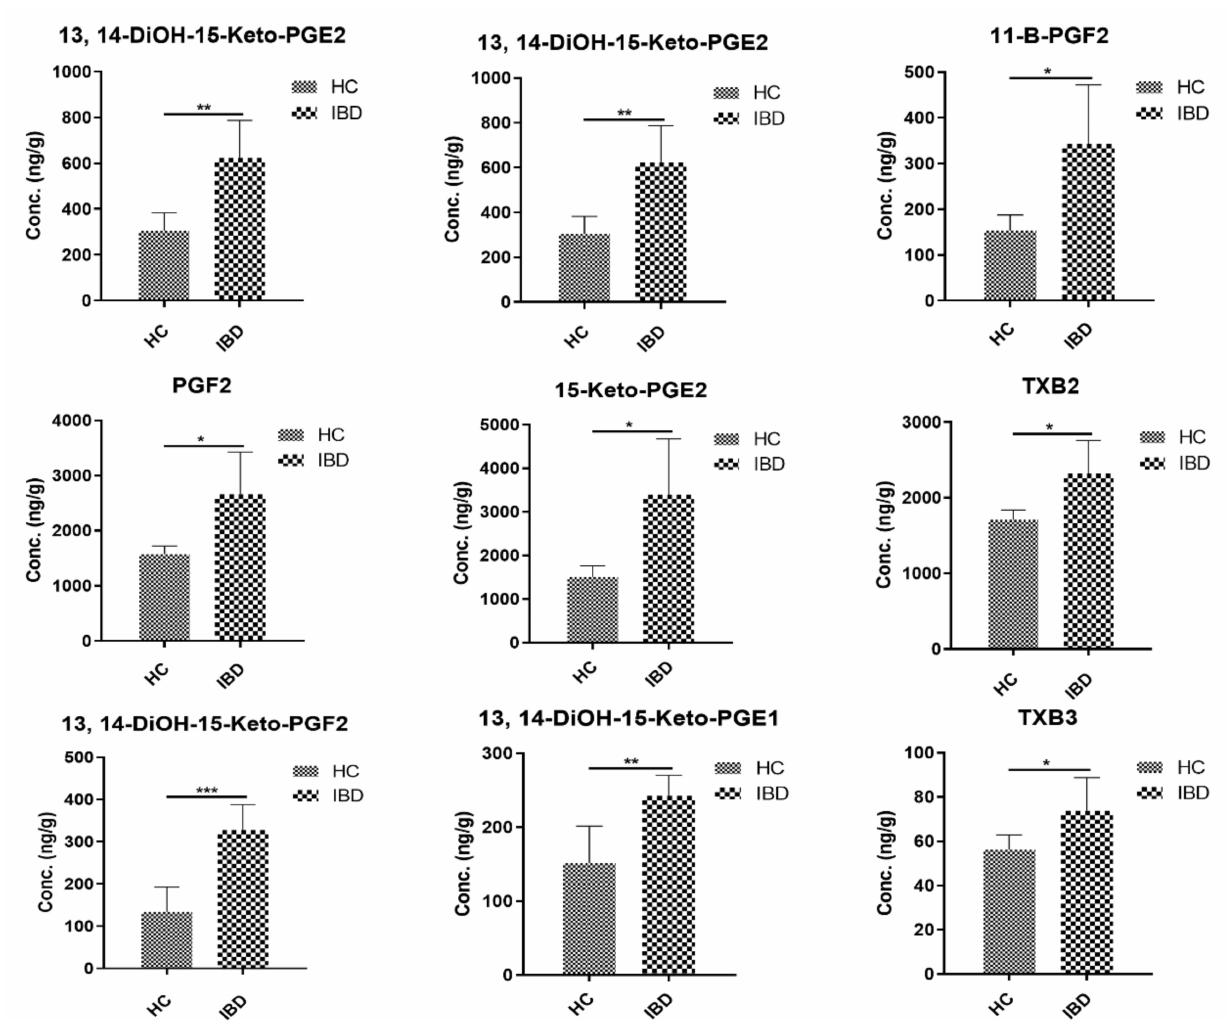
Figure 5. Eicosanoid concentrations in healthy controls (HC) and IBD colon samples. Significance was assessed with the t -test, and all p -values were <0.05 (mean ± SD, n =